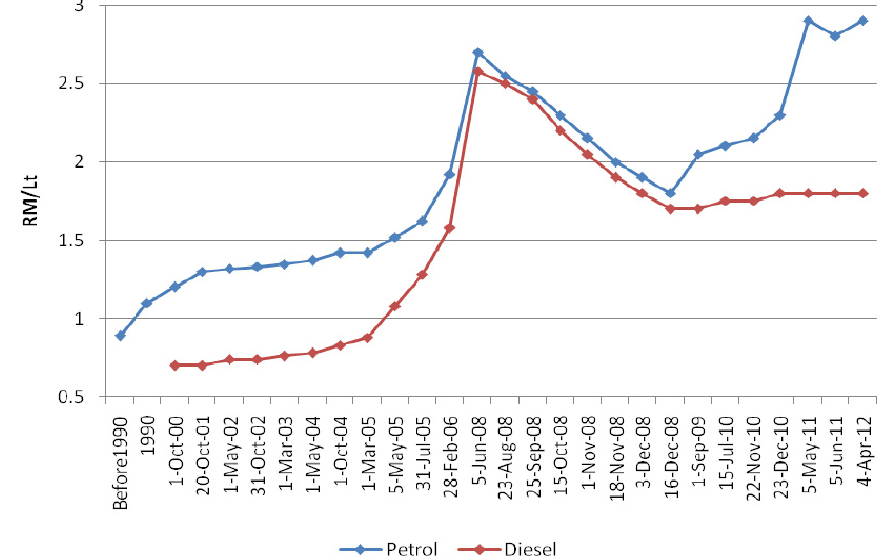
Figure 4. Malaysia’s petrol and diesel price (data source: